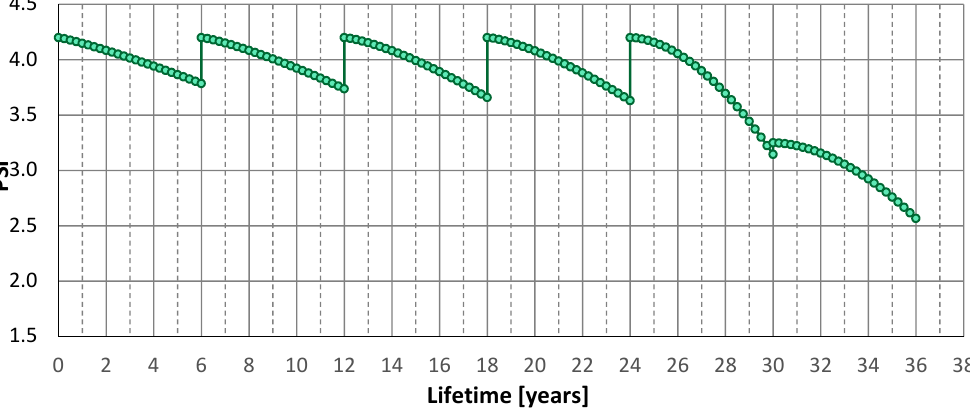
Coatings 2019 , 9 , x FOR PEER REVIEW Figure 1. Present serviceability index (PSI) variation of S–G WR –G DR –D WR –D DR scenarios.